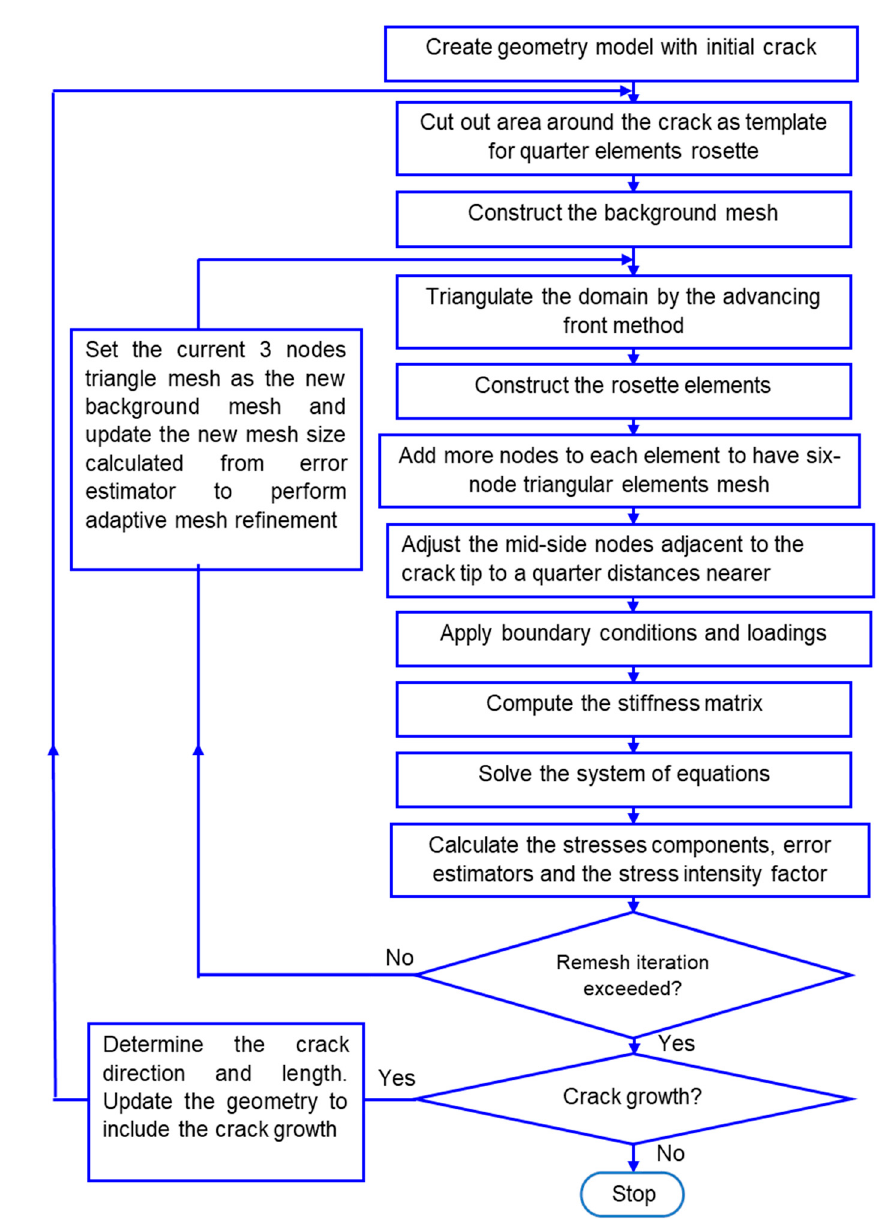
Figure 1. General flow chart of the quasi-static crack growth program.